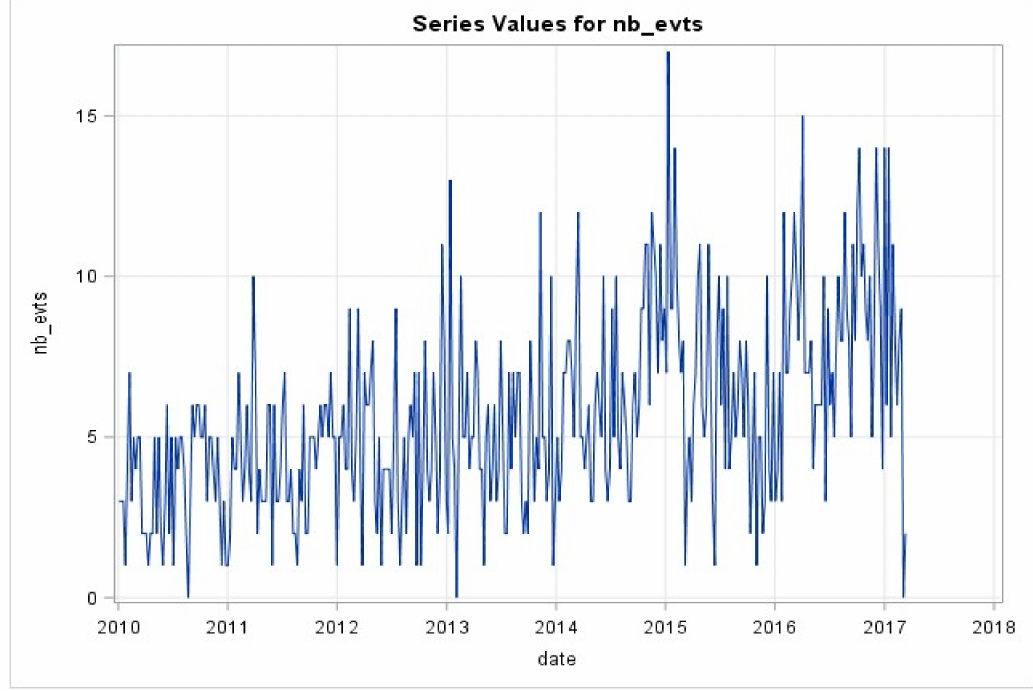
Figure 2. Weekly series of hospitalizations for